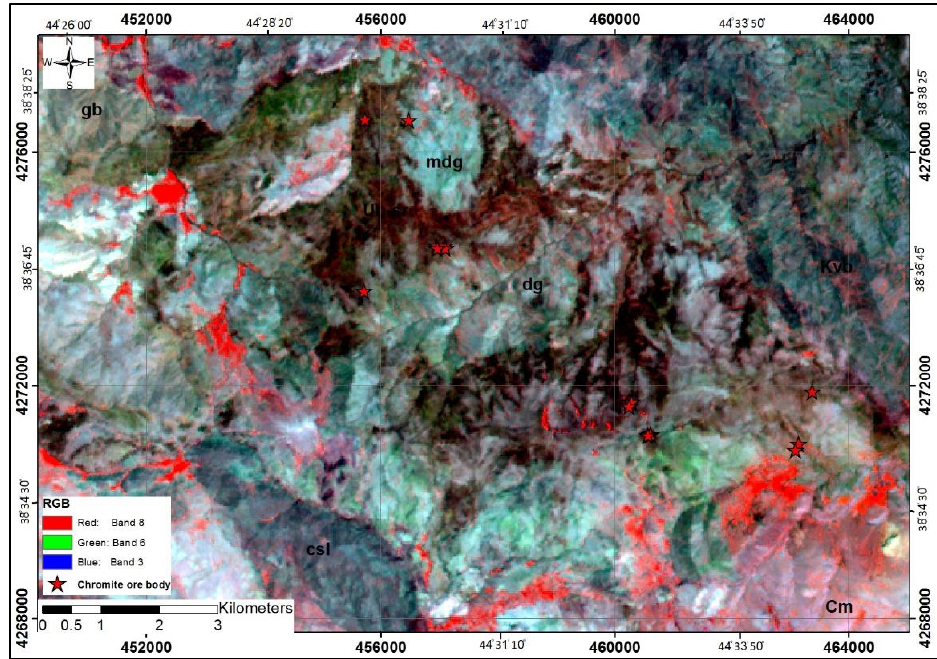
Figure 5. The color composition of RGB (8, 6, 3) from ASTER data after necessary corrections. The satellite images were projected in the UTM Zone N38 and WGS 1984 ellipsoid (oblate spheroid) datum. For mapping the geology units, we can classify similar pixels using the optimum index factor (OIF), band ratio (BR), etc., and obtain the initial map of the lithology units. By using all available data in the study area, a map of lithological units was obtained (Figure 6).